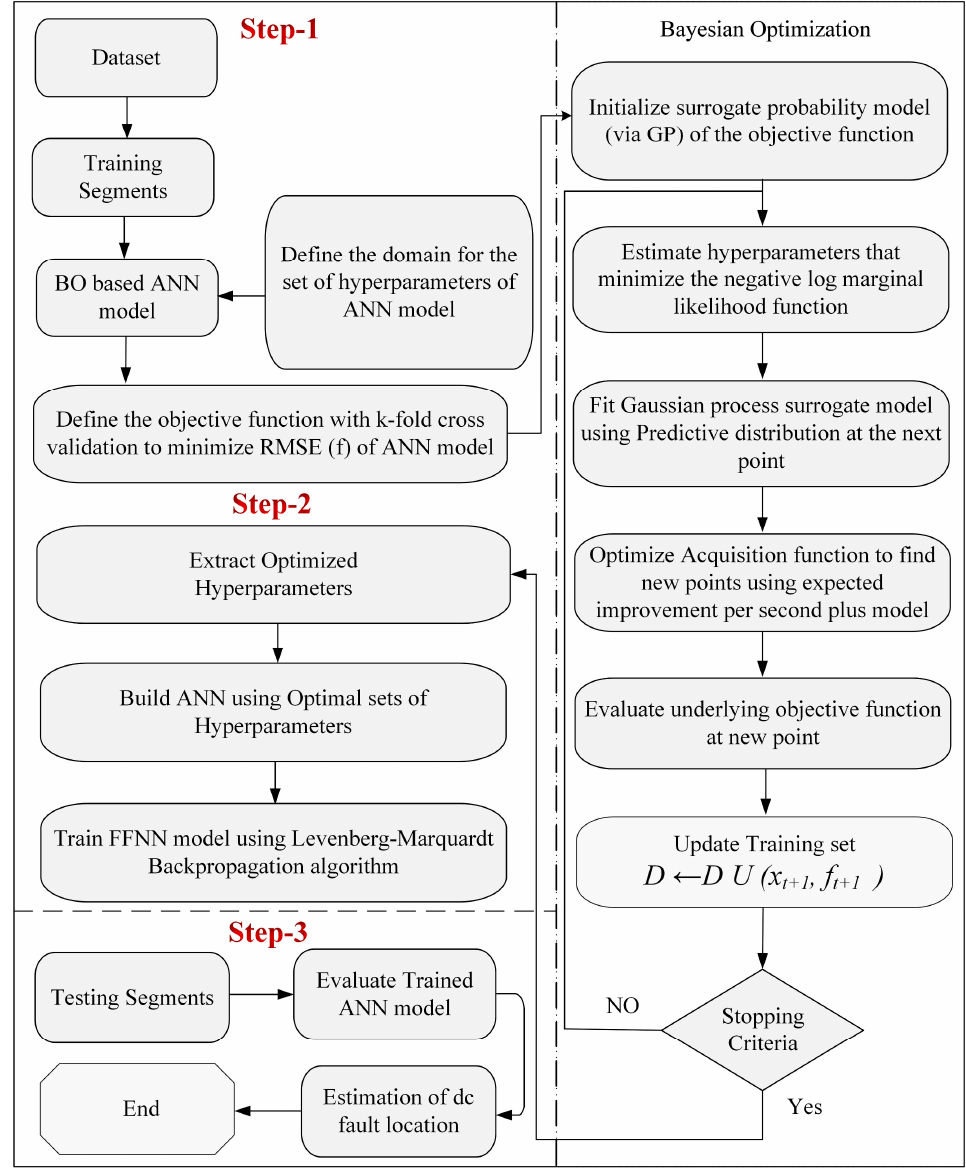
Figure 4. Proposed Framework.